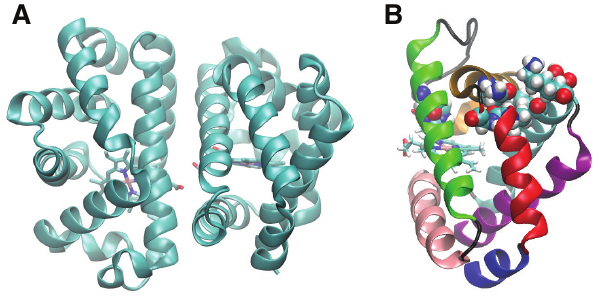
Figure 1. A . Crystal structure of HbI obtained from the protein data bank (ID: 3SDH). B . The helices of HbI are colored as follows: A-blue, B-red, C-ochre, D-orange, E-green, F-pink, G-cyan and H-purple. The residues shown in space-filling representation were found by implicit ligand sampling 10 to be on the major ligand escape. His69 is at the subunit interface on the E alpha helix, and the rest of the residues form a channel between the B and G helices; including Ile25, Asn32, Ala35, Leu36, Val121, Ser124, and Lys125. The E and F helices are involved in intra-subunit communication. The BG pathway is adjacent to the Xe4 cavity (Figure 2B), allowing escape between these two